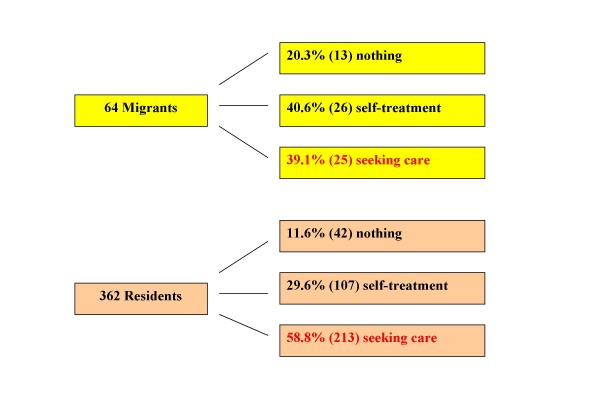
Comparison of health seeking behaviour among migrants and residents who were still suffering from the symptoms in the follow-up survey. The chart compares the measures taken in the follow-up survey among the migrants and the residents who were still suffering from the symptoms.